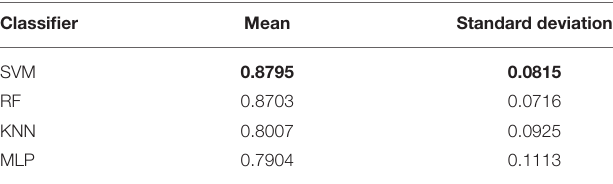
TABLE 1 | Means and standard deviations of AUC for 100 tests of the ML classifier.